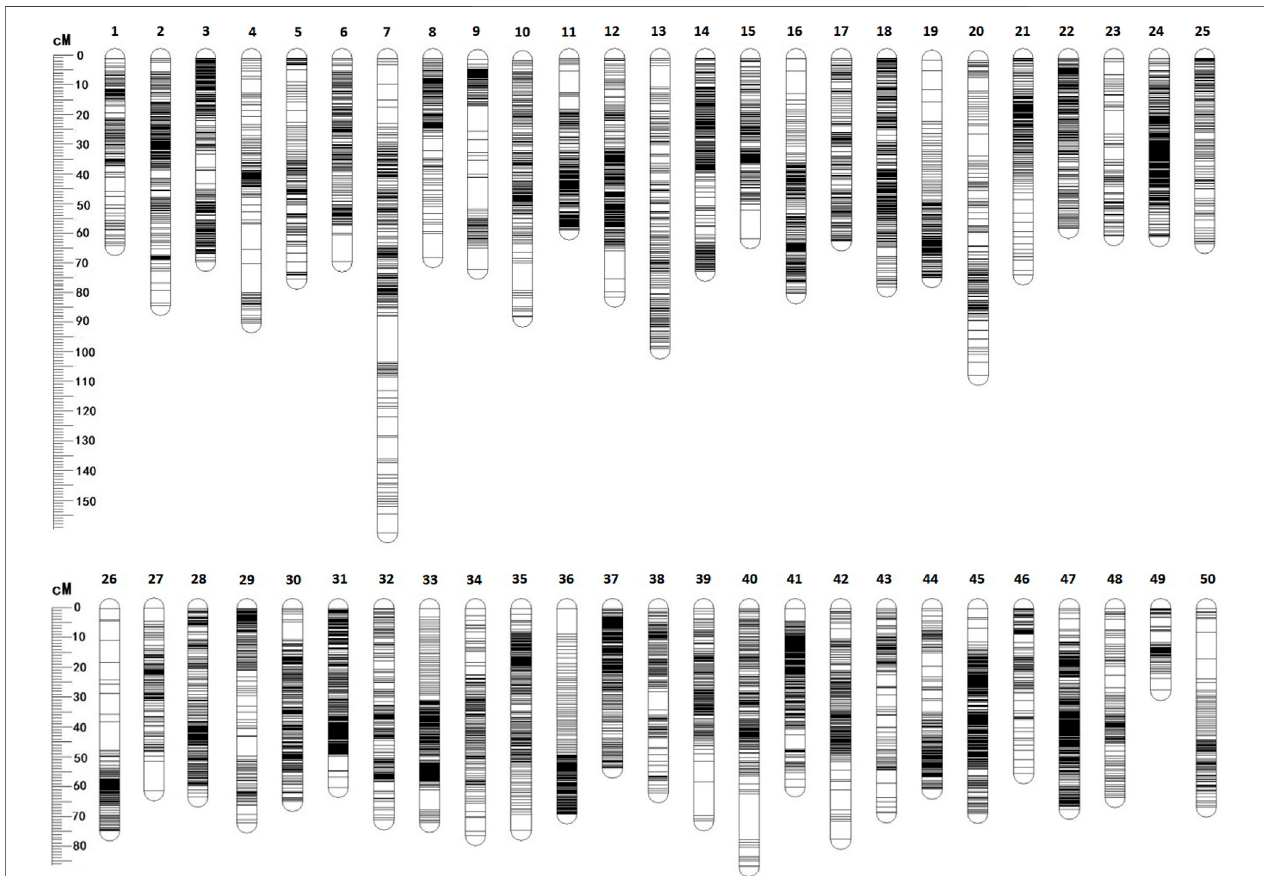
FIGURE 1 | The high-density linkage genetic map for mirror